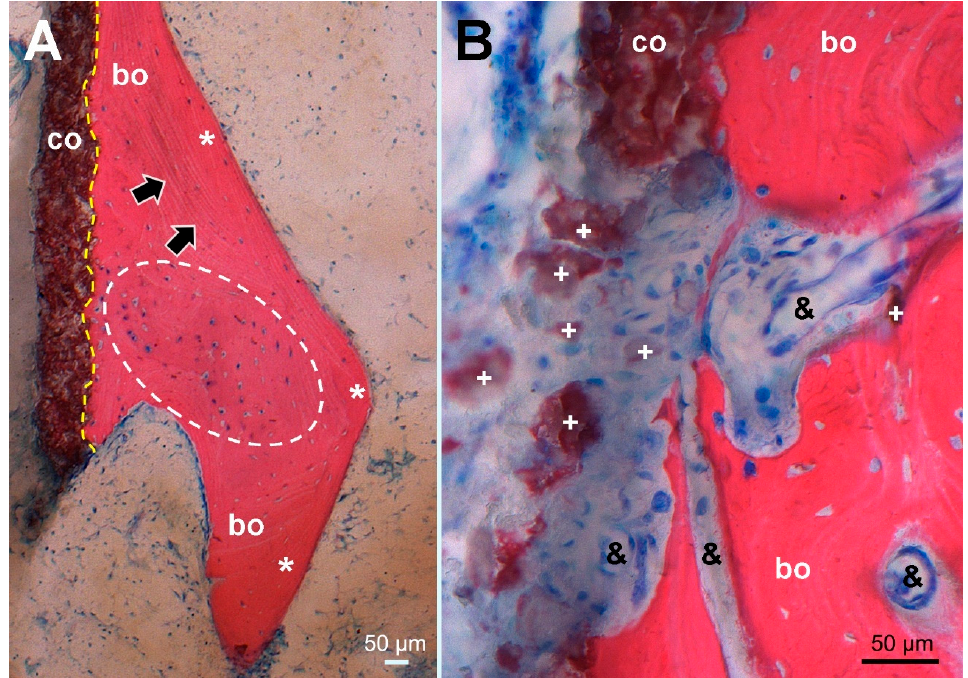
Figure 5. Histological picture (stained Giemsa–Eosin) of tissue sampled at the site corresponding to the dense line (arrowheads) in Figure 1C, maintaining the same orientation. ( A ) Overview of the HA coating (co, stained brown) showing firm bonding (dashed yellow line) to ongrown bone (bo, stained red) consisting of mature lamellar bone (*, black arrows marking lamellar orientation) surrounding newly formed woven bone (encircled by a white dashed line). In nearly all osteocyte lacunae, blue stained osteocyte nuclei indicate bone viability. ( B ) higher magnification of an HA coating defect with dispersed HA fragments (+) surrounded by fibrous scar tissue encompassing proliferated capillaries (&) and extending into resorption lacunae of remodeled woven bone without cellular inflammatory reaction. Materials 2020 , 13 , x